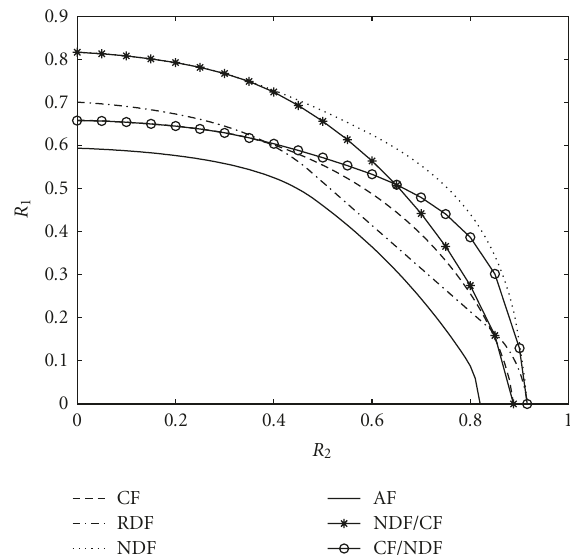
Figure 13: Comparison between the achievable rate regions when using the same relaying strategy for both users and when using di ff erent relaying strategies, for Scenario